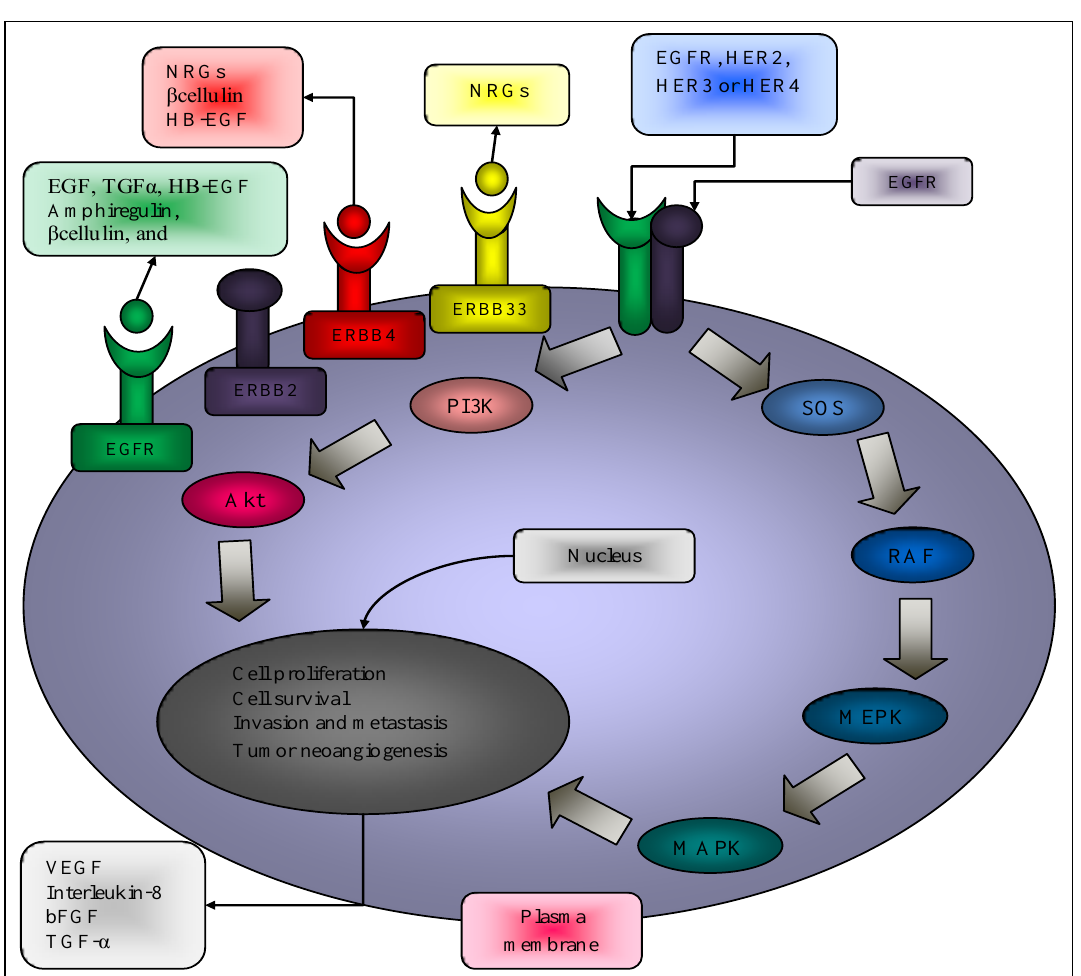
Figure 1. Signal Transduction Pathways controlled by the activation of epidermal growth factor receptors (EGFR). Three steps can be defined in the activation of EGFR-dependent intracellular signaling. First, the binding of a receptor specific ligand occurs in the extracellular portion of the EGFR or one of the EGFR-related receptors (ERBB2, ERBB3 or ERBB4). Second the formation of a functionally active EGFR-EGFR dimer or an EGFR-ERBB2, EGFR-ERBB3 or EGFR-ERBB4 dimer, causes the ATP-dependent phosphorylation of specific tyrosine residues in the EGFR intracellular domain. Third, this phosphorylation triggers a complex program of intracellular signals to the cytoplasm and then to the nucleus. The two major intracellular pathways activated by EGFR are the RAS-RAF-MEK-MAPK pathway, which controls gene transcription, cell-cycle progression from G1 to S phase, and cell proliferation, and the P13K-Akt pathway, which activates a cascade of anti-apoptotic and pro-survival signals. Legend: Akt: protein kinase B, HB-EGF: heparin binding epidermal growth factor, bFGF: basic fibroblast growth factor, MAPK: mitogen-activated protein kinase P, PI3K: phosphatidylinositol 3,4,5-kinase, TGF-α: transforming growth factor receptor alpha, VEGF: vascular endothelial growth factor, SOS: factor son of sevenless (Adapted from Ciardiello et al .